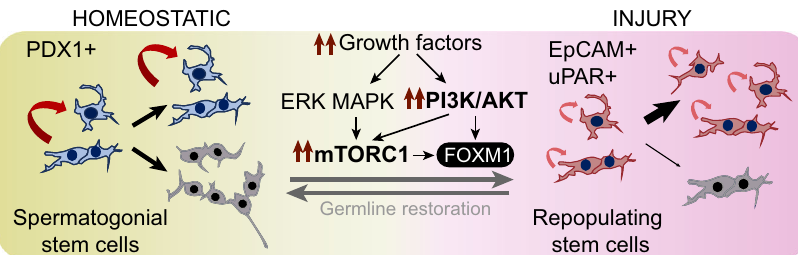
Fig. 7 Model illustrating distinct states of homoeostatic and regenerative A undiff plus pathways regulating interconversion. Homoeostatic SSCs are marked by PDX1, undergo balanced self-renewal (curved arrows) and differentiation commitment (grey syncytia) and are optimised for life-long germline maintenance. In response to germ cell loss, increased growth factor stimulation hyperactivates PI3K/AKT and mTORC1 signalling pathways in surviving A undiff and drives adoption of a unique, highly proliferative state marked by EpCAM and uPAR that is biased towards self-renewal (regenerative A undiff or ‘ repopulating stem cells ’ ). Regenerative A undiff properties are optimised for rapid germline regeneration, but long-term germline maintenance capacity is limited (small, curved arrows). Transcription factor FOXM1 is a downstream effector of growth factor-dependent signalling in A undiff and promotes increased cell cycle progression characteristic of regenerative A undiff . Expression of uPAR can underlie an increased migratory capacity. Following recovery of the spermatogonial pool and declining growth factor stimulation, regenerative A undiff transition back to a homoeostatic state to preserve life-long germline